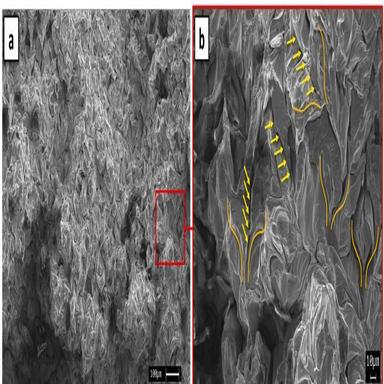
SEM images of "AM.m.V.1" specimen fracture surface; intergranular fracture displaying at two magnification.